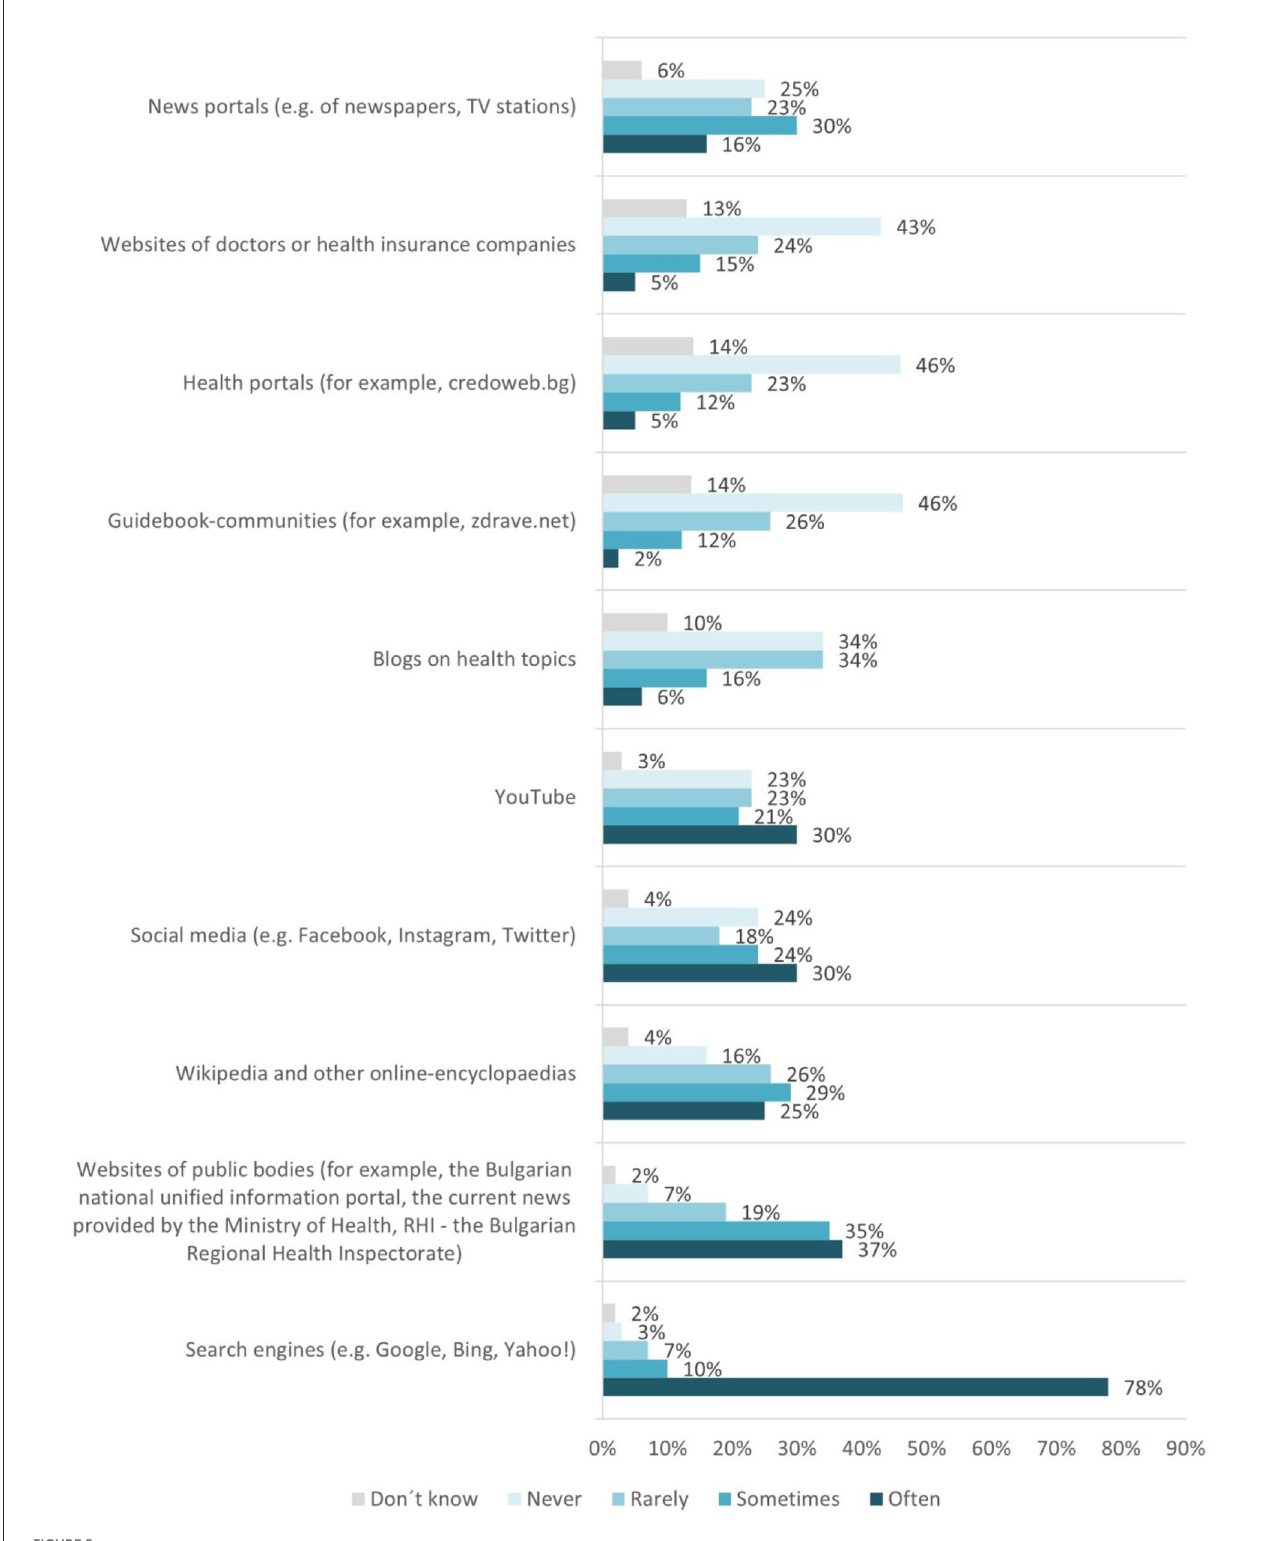
FIGURE5 Sources used by the students to get information about the coronavirus and related topics on the Internet.